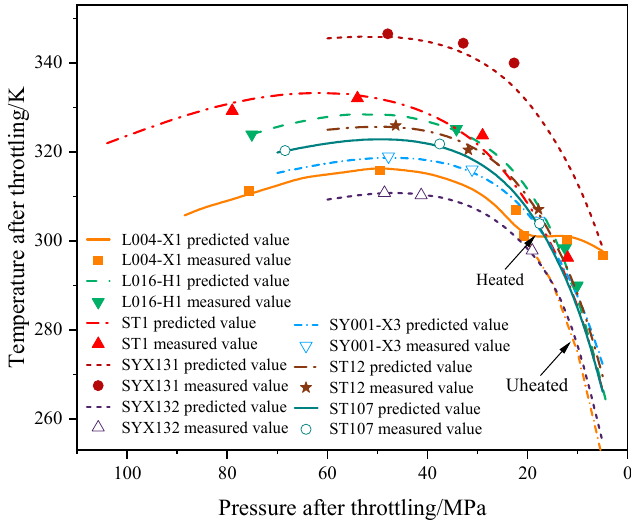
Figure 2. Prediction of surface throttling temperature drop curve.